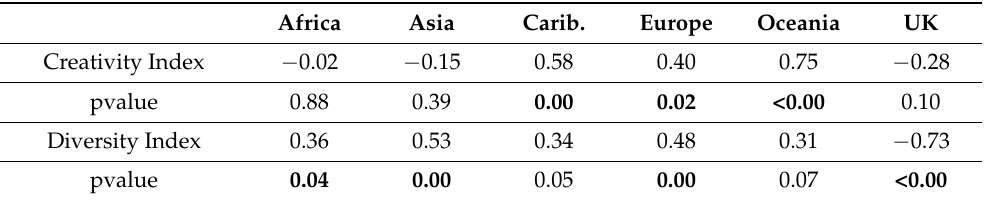
Table 7. Pearson correlation coefficients between the Diversity and Creativity Indices and geographic regions of